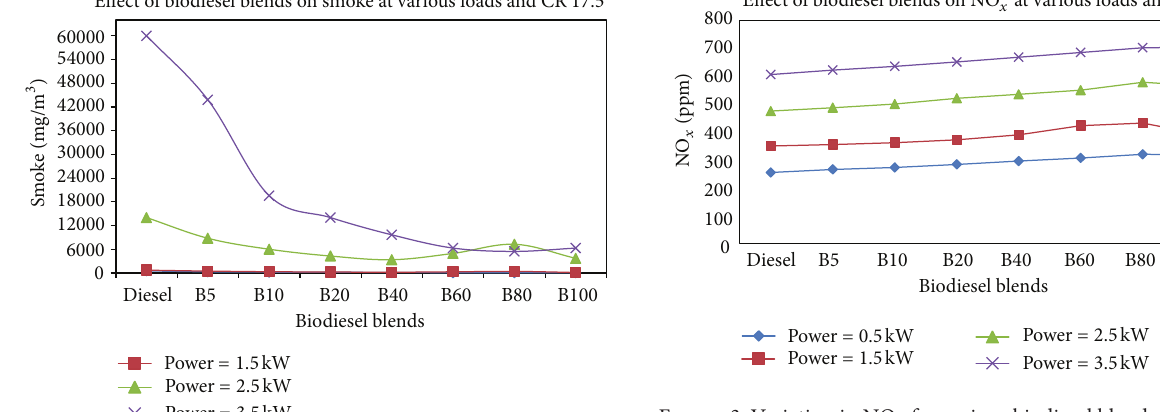
Figure 3: Variation in NO 𝑥 for various biodiesel blends at different